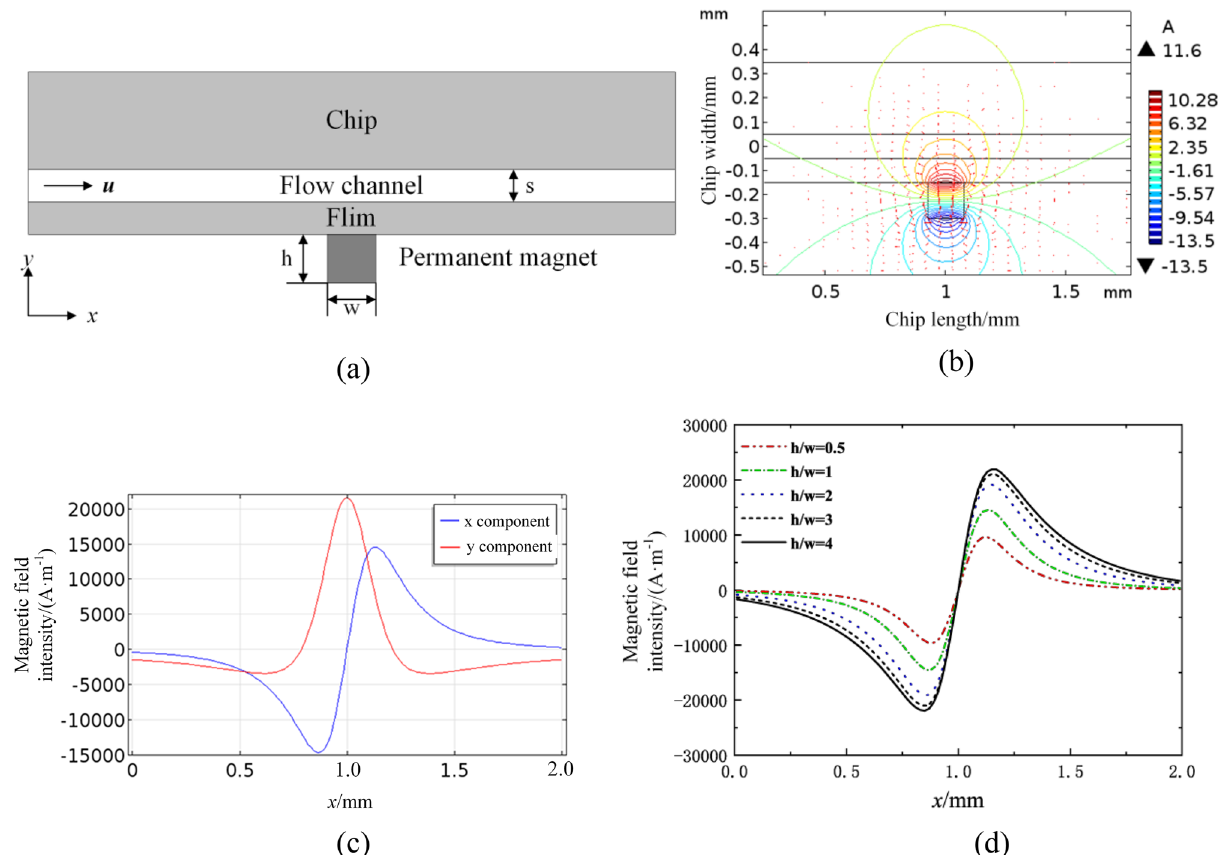
Figure 11. Numerical simulation for magnetic field. ( a ) 2D analysis model. ( b ) Spatial distribution of magnetic field. ( c ) Magnetic field intensity component in microchannel centerline. ( d ) Magnetic field x components of microchannel centerline with different aspect